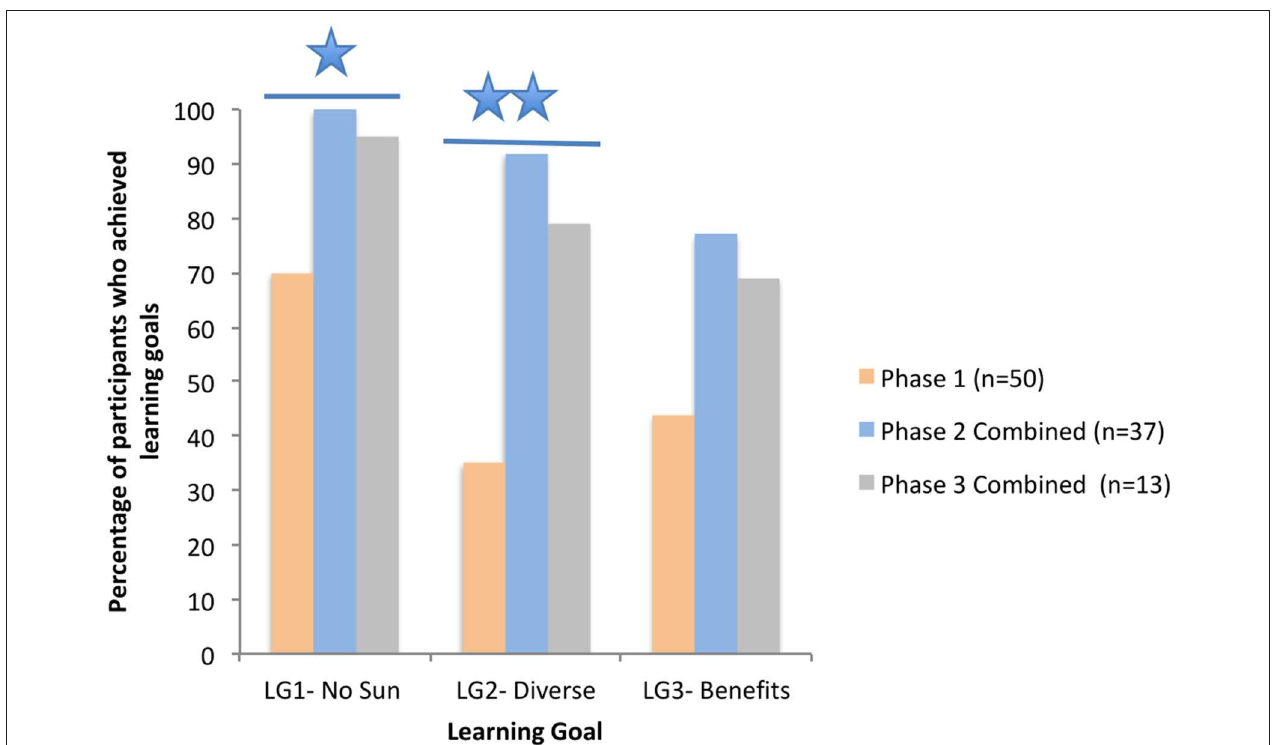
FIGURE 2 | Percentage of participants who achieved learning goals, star indicates significance at * p < 0.05 and ** p < 0.001. Phase 1 ( n = 50): Baseline participants did not view the exhibit, while Phase 2 ( n = 37) participants took the questionnaire after viewing exhibit Iteration A, B, or C, and Phase 3 ( n = 13) participants responded to the questionnaire 1 month after their visit (LG = Learning